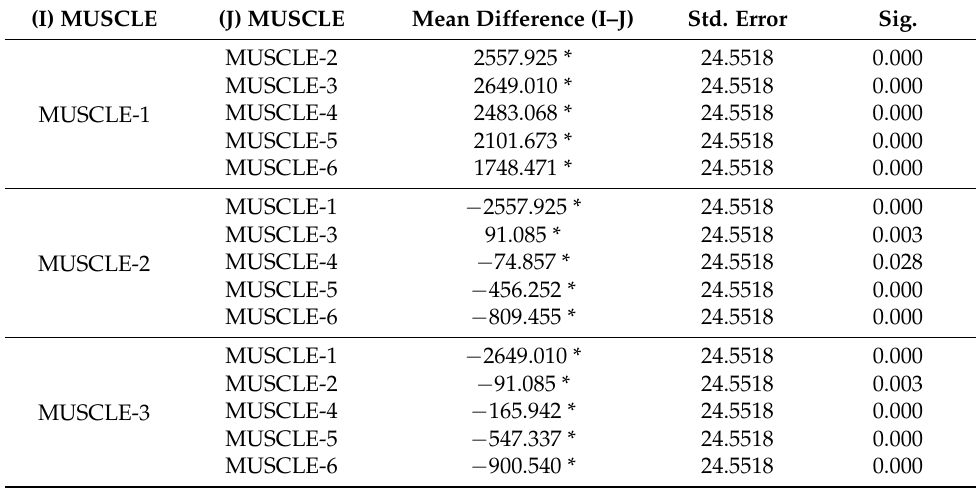
Table A2. iEMG value and Tukey HSD for